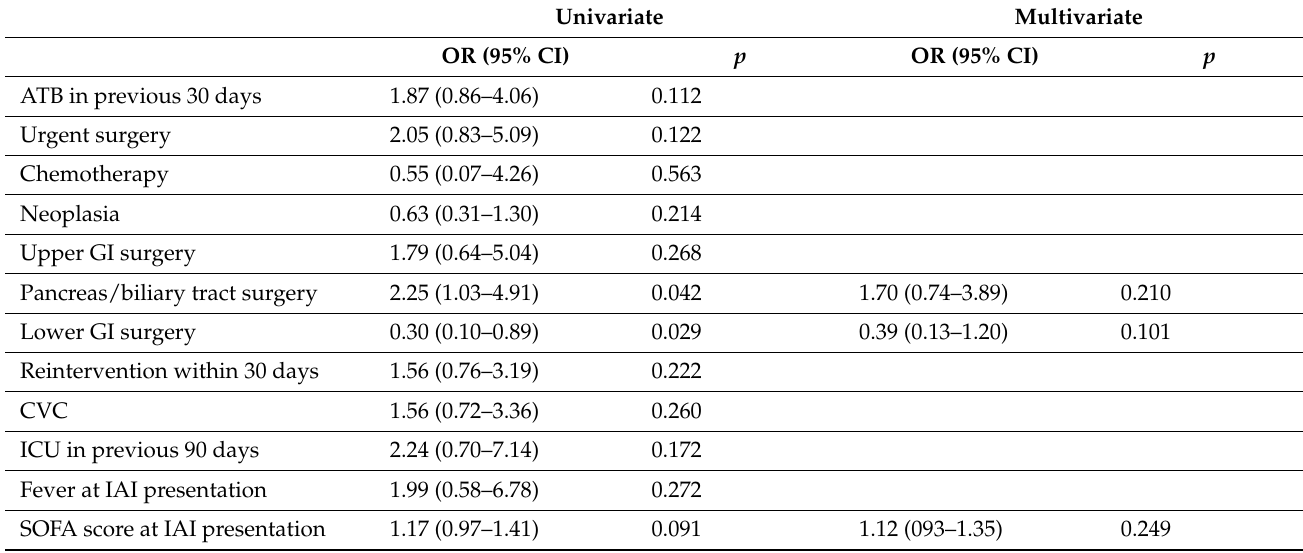
Table 3. Factors associated with Candida isolation from the abdomen in the overall population (n = 319).